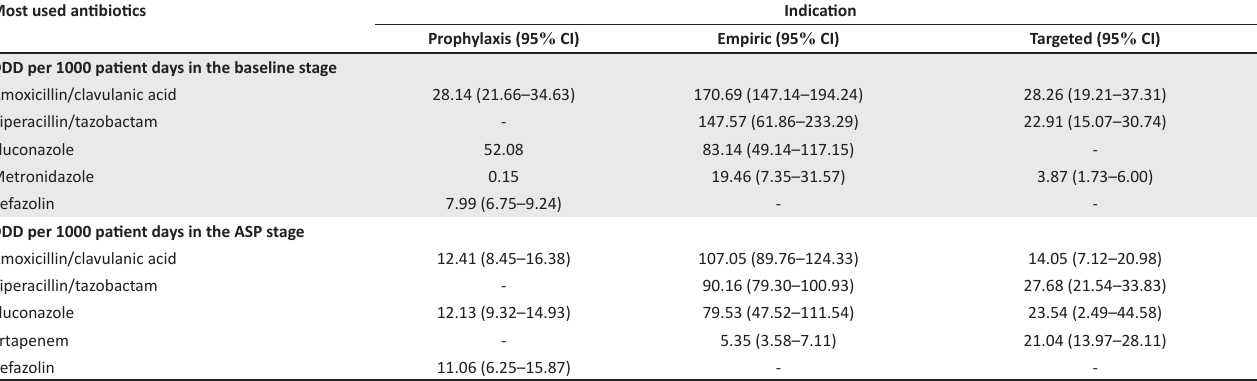
TABLE 1-A3: Consumption of most frequently used